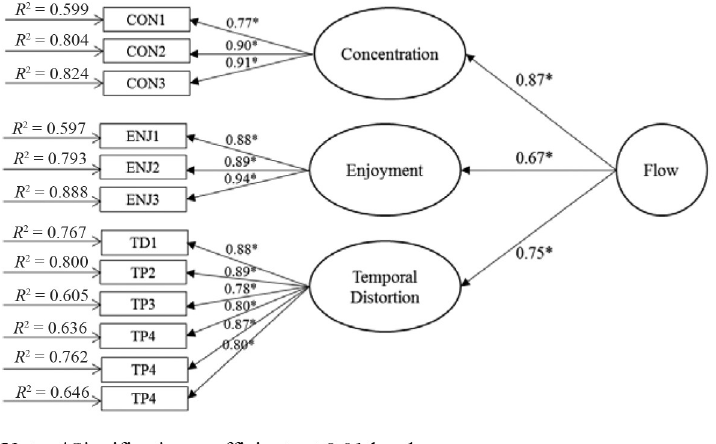
Figure 2. Second-order model of